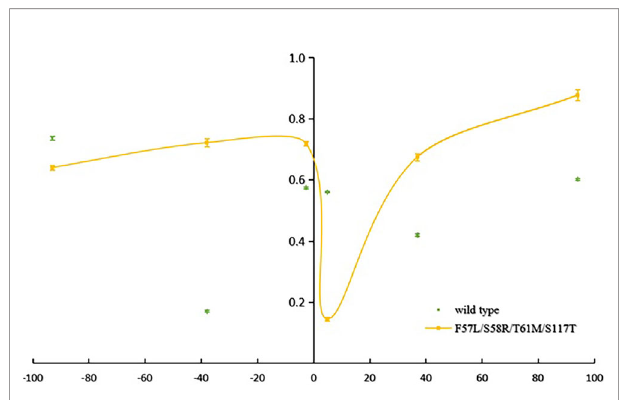
FIGURE 2 | Reduced haplotype diversity proximate to mutant pvdhfr alleles in parasites sampled from Lazia (He, compared to wild type).